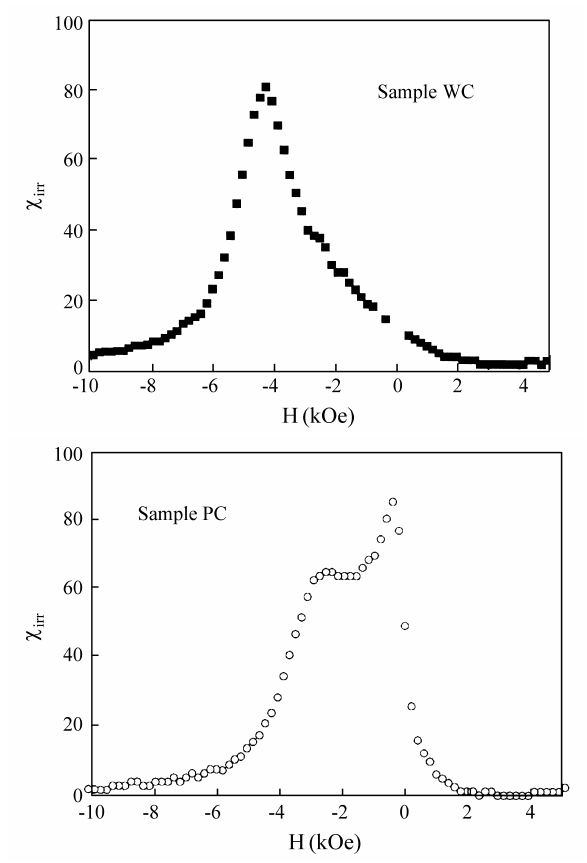
Figure 7. Coercive field H c vs. flash-annealing temperature T a for 30 s anneal for all samples